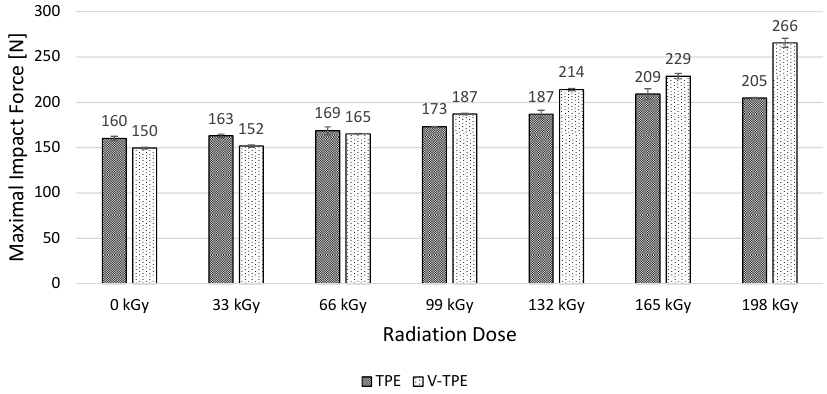
Figure 16. Maximal impact force—TPE,